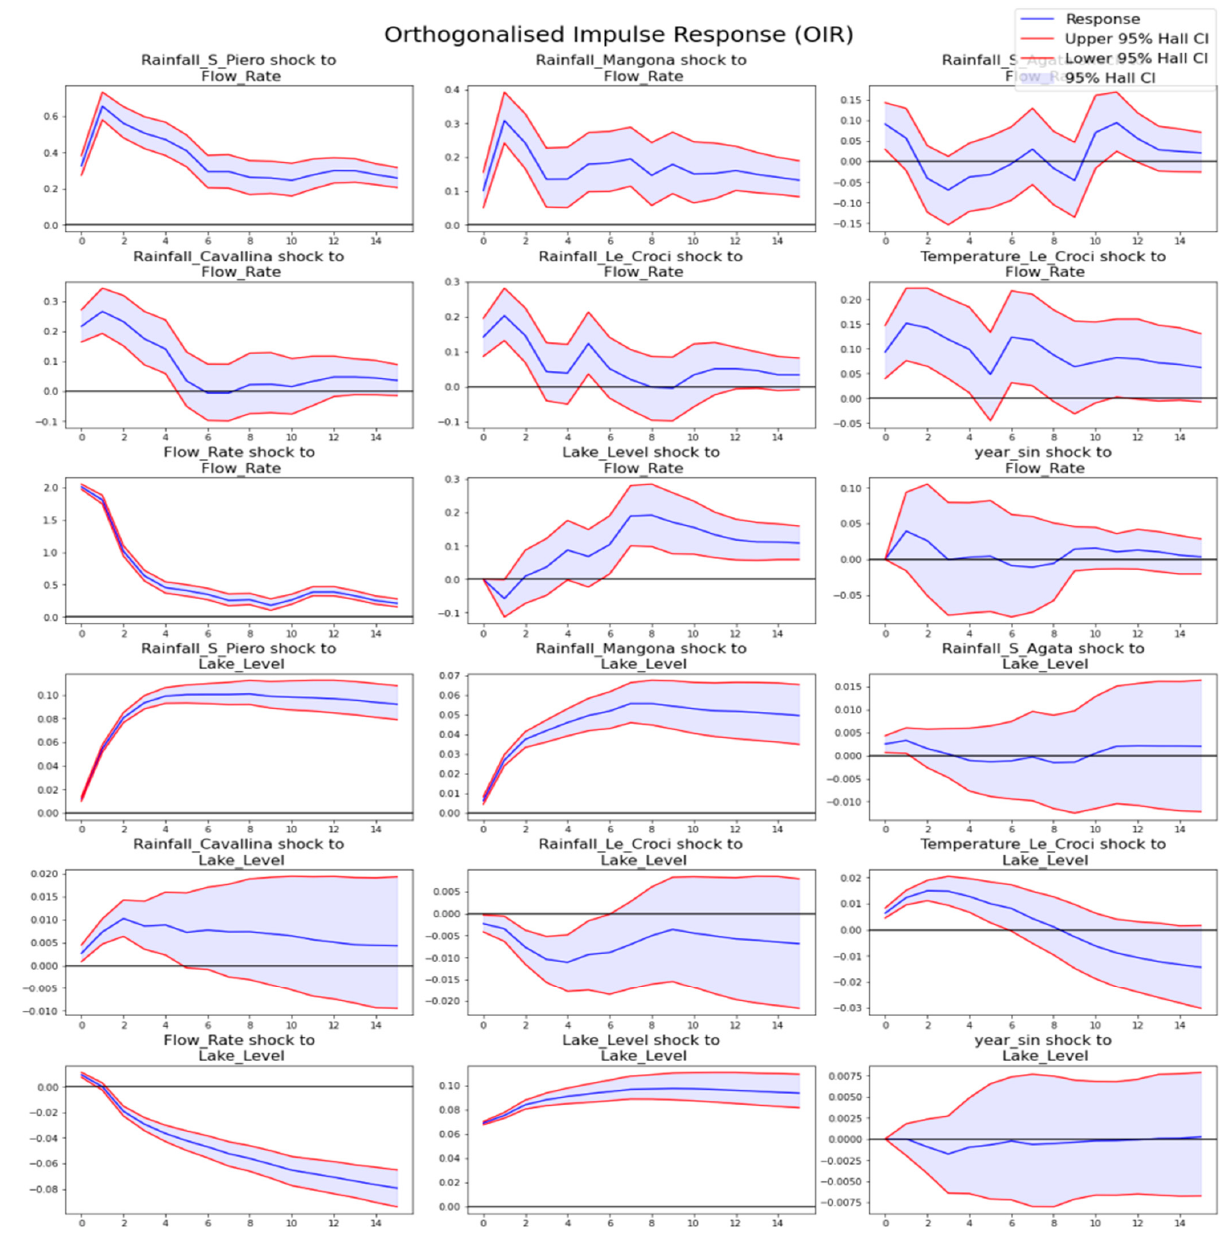
Figure 8. OIR plot for Flow_rate and Lake_level (LAKE-BILANCINO).